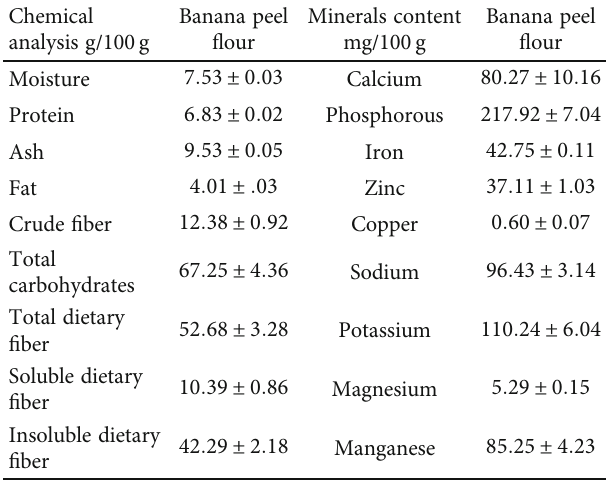
Table 1: Nutritional values of banana peel fl our on dry weight. Chemical analysis g/100 g